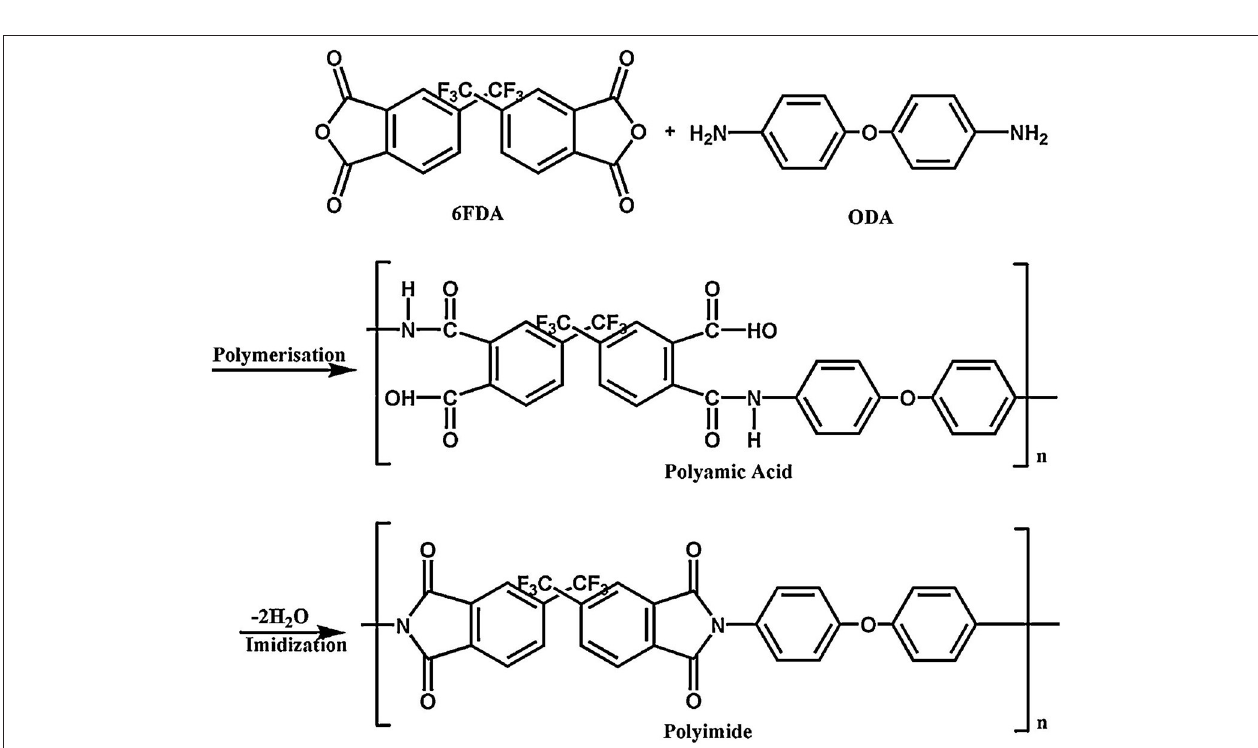
FIGURE 7 | Schematic representation of the polymerization of 6FDA-ODA polyimide. Reproduced from Nik et al. (2012). Copyright obtained from Elsevier (license number 4681851097497).